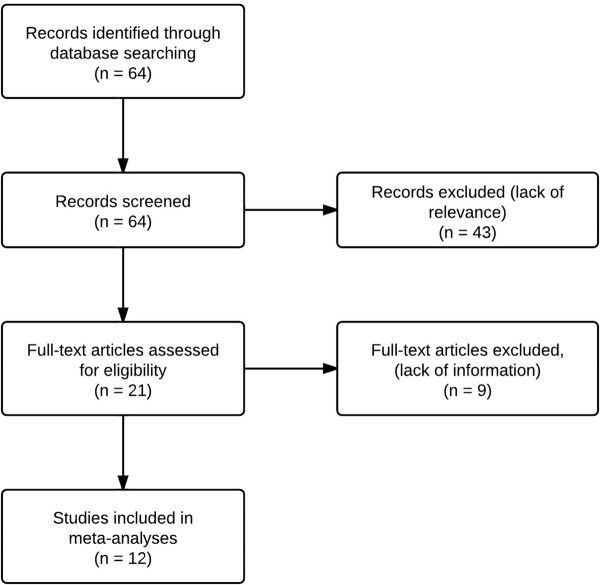
Study selection [23].